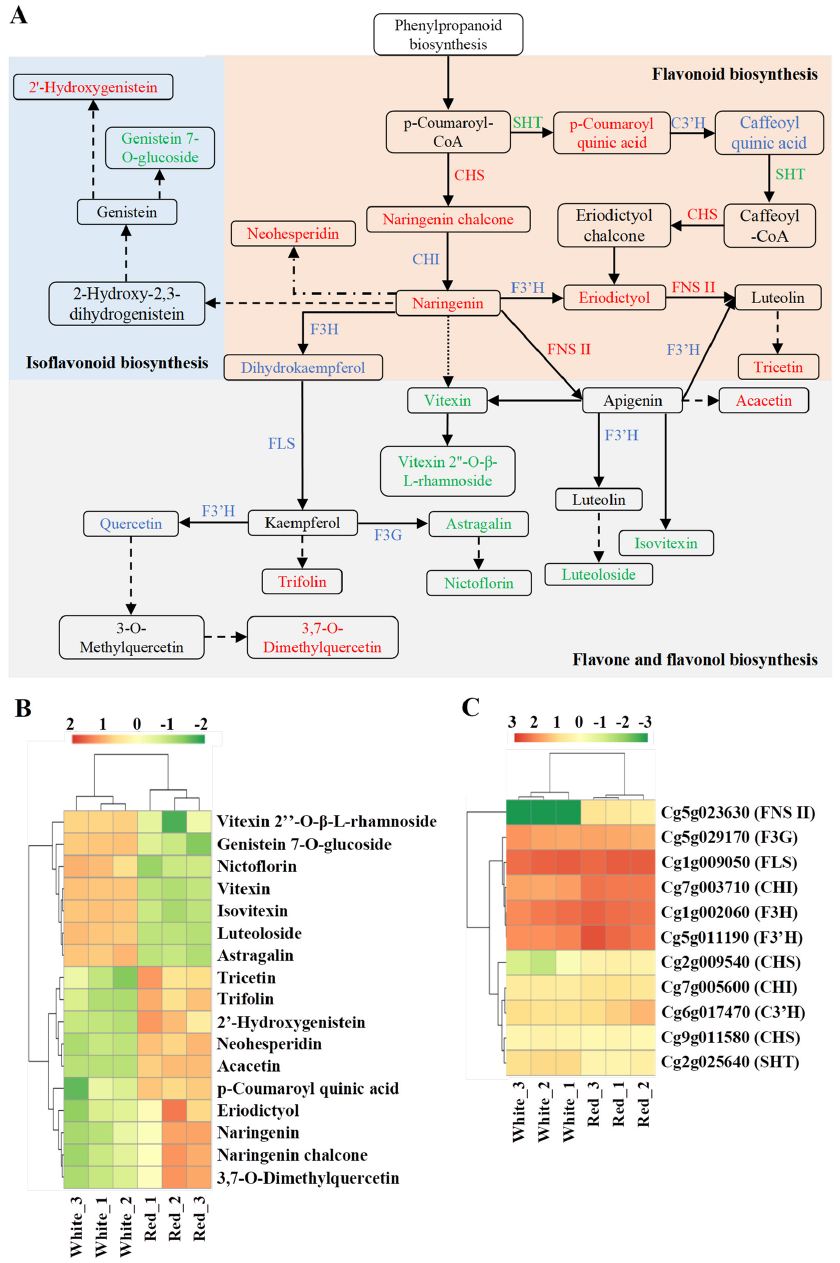
Figure 6. Pathway analysis of flavonoid biosynthesis. ( A ) Flavonoid biosynthesis pathway in pomelo. Solid arrow: molecular interaction or relation; dashed arrow, no genes were detected; dotted arrow, no metabolites were detected; point-line arrow, no genes or metabolites were detected. CHI: chalcone isomerase; CHS: chalcone synthase; C3’H: 5–O–(4-coumaroyl)–D–quinate/shikimate 3’–hydroxylase; F3G: flavonol 3–O–glucosyltransferase; F3H: flavanone 3–hydroxylase; F3’H: fla- vonoid 3’–hydroxylase; FLS: flavonol synthase; FNS II: flavone synthase II; SHT: shikimate O–